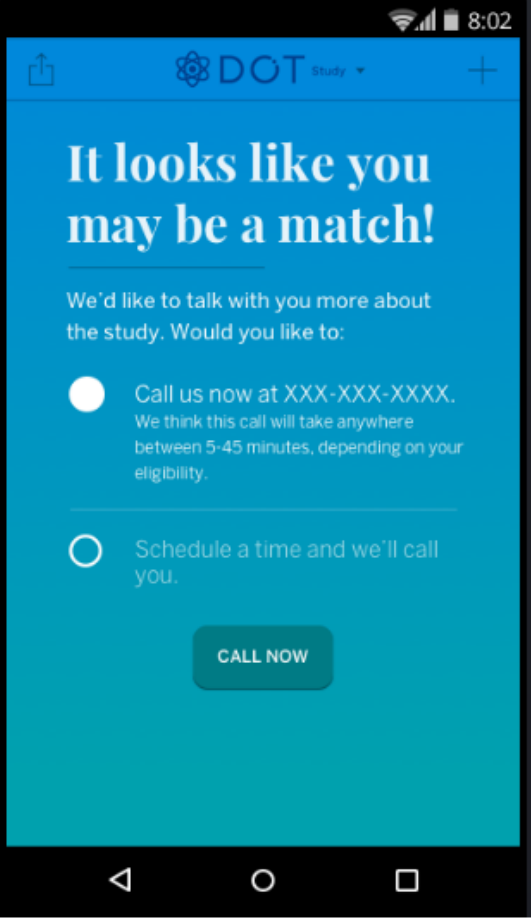
Figure 3. The pop-up screen after women were determined to be